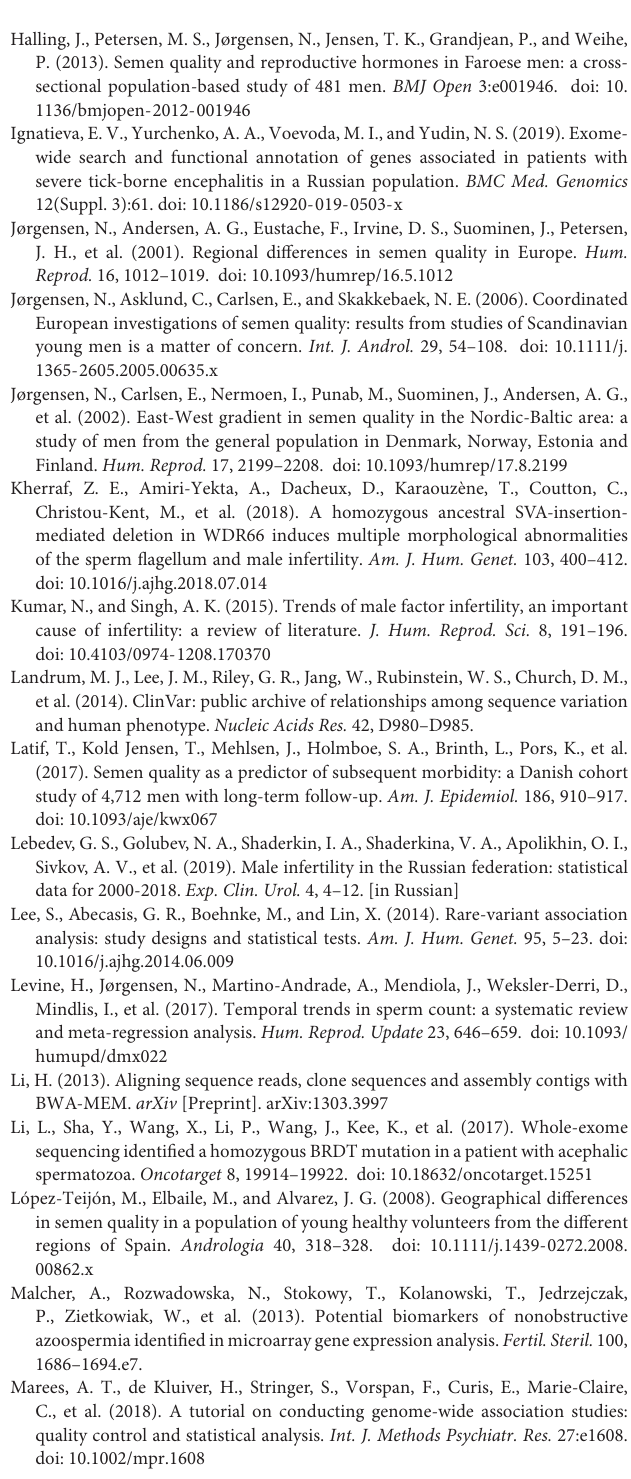
Supplementary File 9 | Top-100 results of association analysis using log-regression model for the Yakut subgroup combined with VEP results, Protein Expression Atlas normalized expression values for genes harboring polymorphisms and genes associated with male infertility from DisGeNET. Supplementary File 10 | Results of rare-variant analysis for the whole sample using